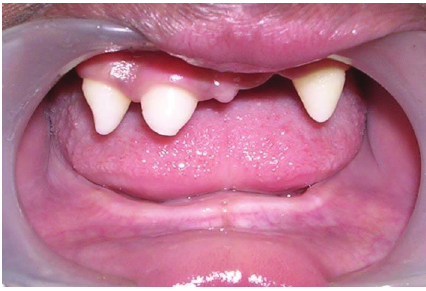
Figure 2: Pretreatment intraoral view.